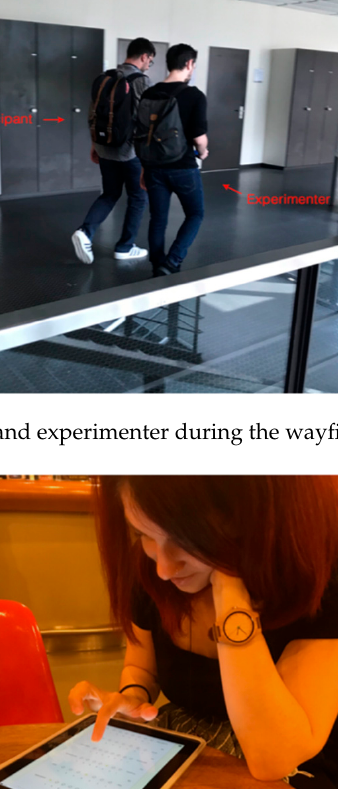
Figure 17. Integration of axonometric-based landmarks within the routing instructions (based on pilot study feedback).